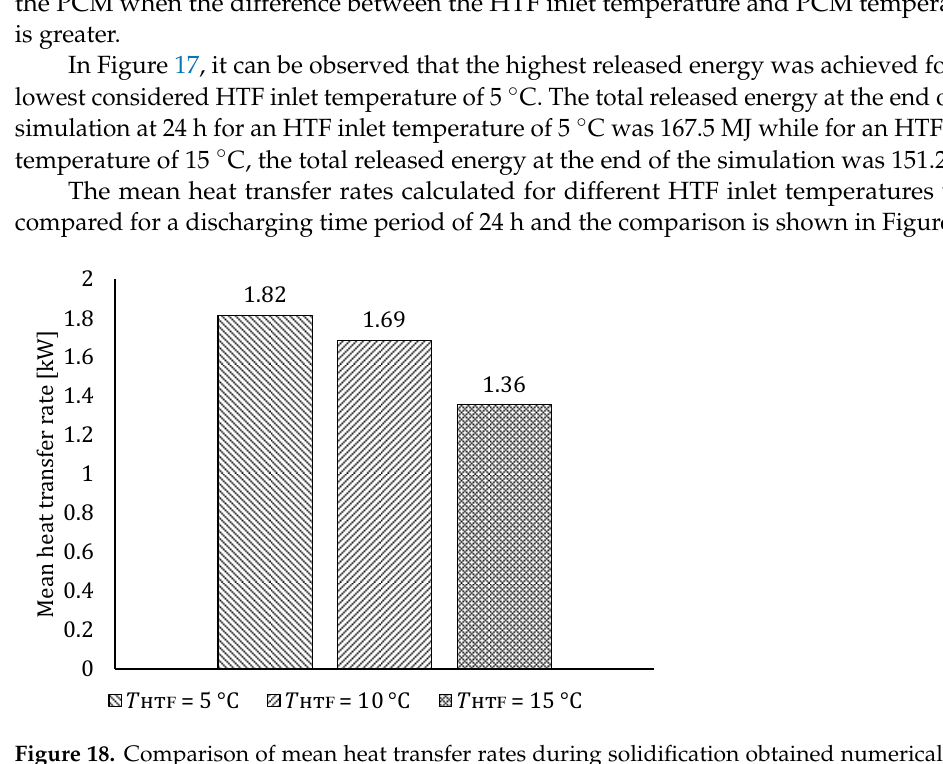
Figure 18. Comparison of mean heat transfer rates during solidification obtained numerically for different HTF temperatures, HTF inlet flow rate 800 l/h and initial PCM temperature 35 °C.